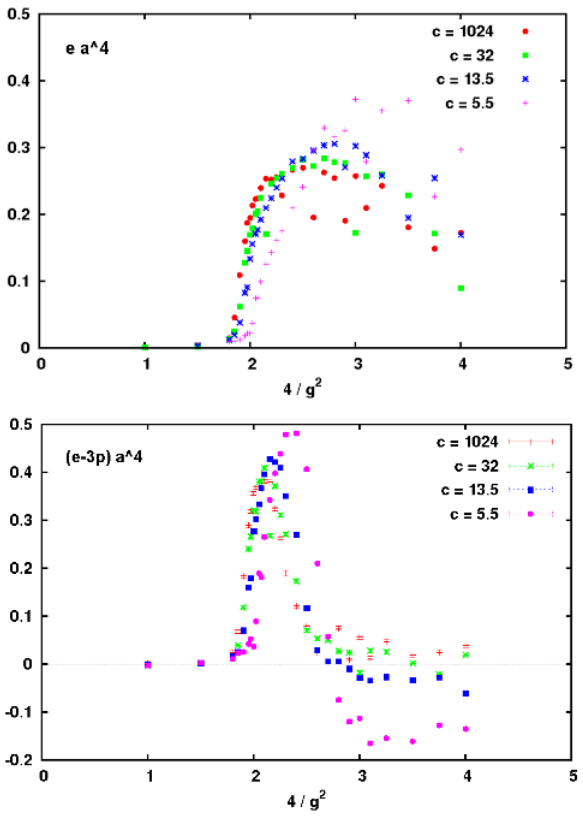
Fig. 5. The energy density and the interaction measure in lattice units vs. coupling for the Tsallis parameters c = 5 . 5 , 13 . 5 , 32 . 0 , and 1024 . 0.